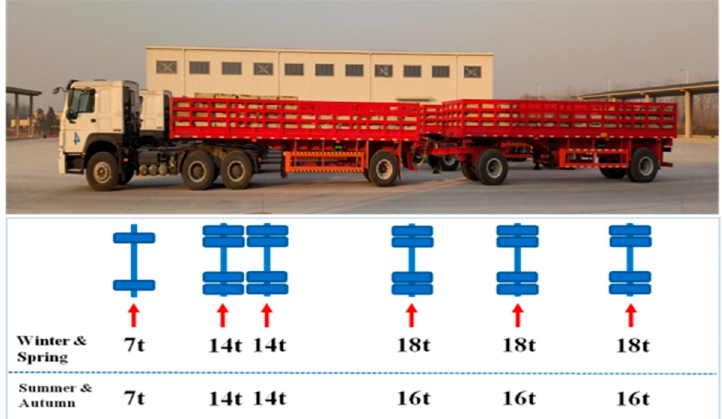
Figure 4. Axle load and axial distribution of trucks in loading mode II.